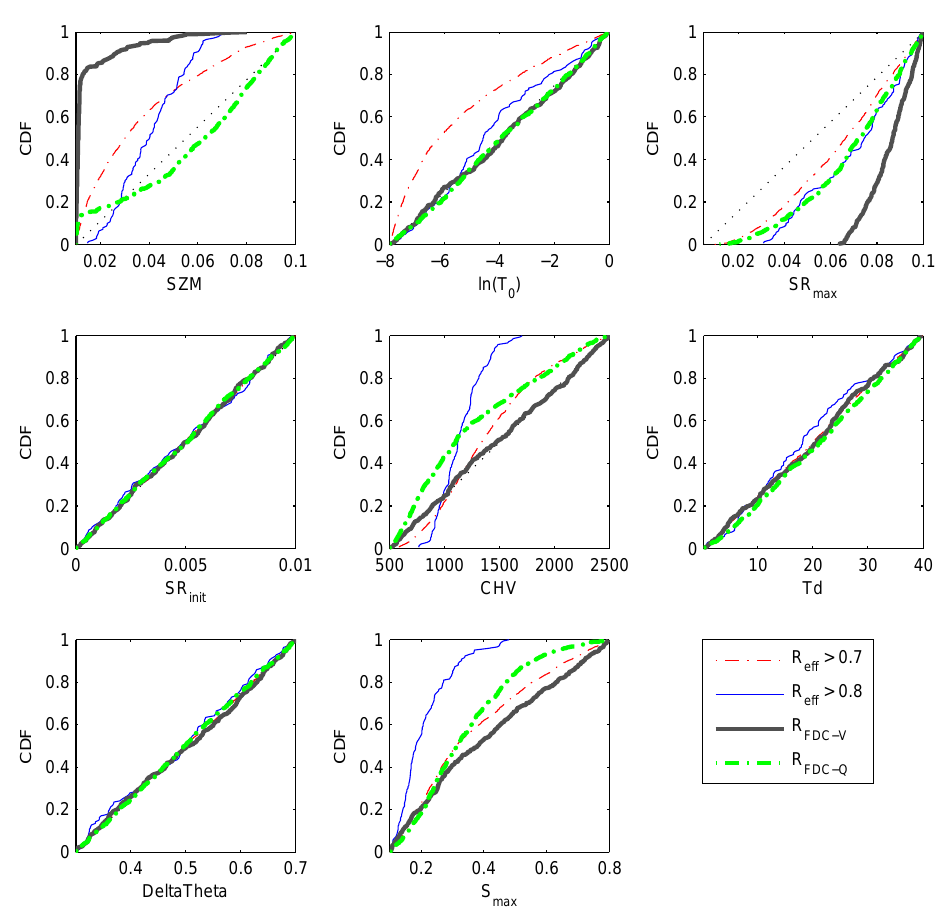
Fig. 8. Cumulative informal likelihood distributions for all Dynamic TOPMODEL parameters (the parameter names are explained in Table 2). The informal likelihood weights for each performance measure were calculated for the calibration in 1995–1996 in the Brue